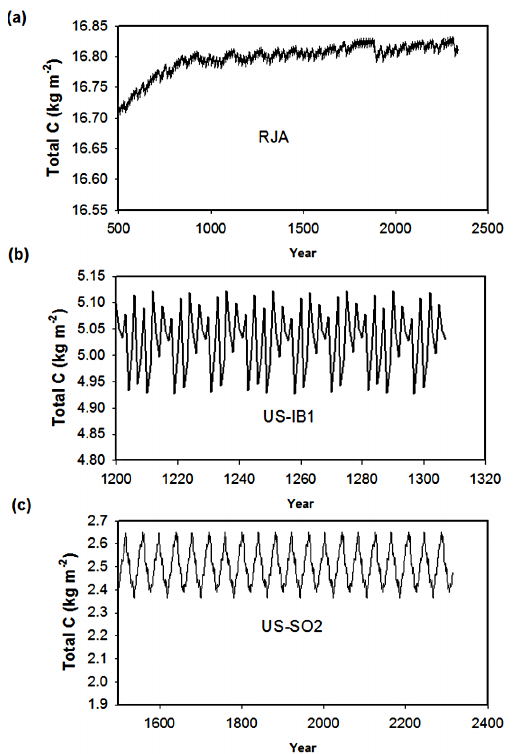
Figure 5. Comparison of water table depth (a) , average soil mois- ture content (b) , and average soil temperature (c) using the original soil hydrology model and STOMP in CLM4 at site